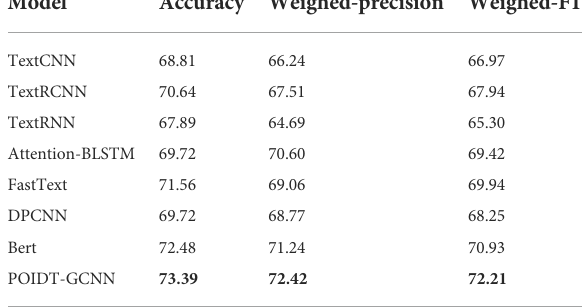
TABLE 2 Performance comparison of defect text classi fi cation models.